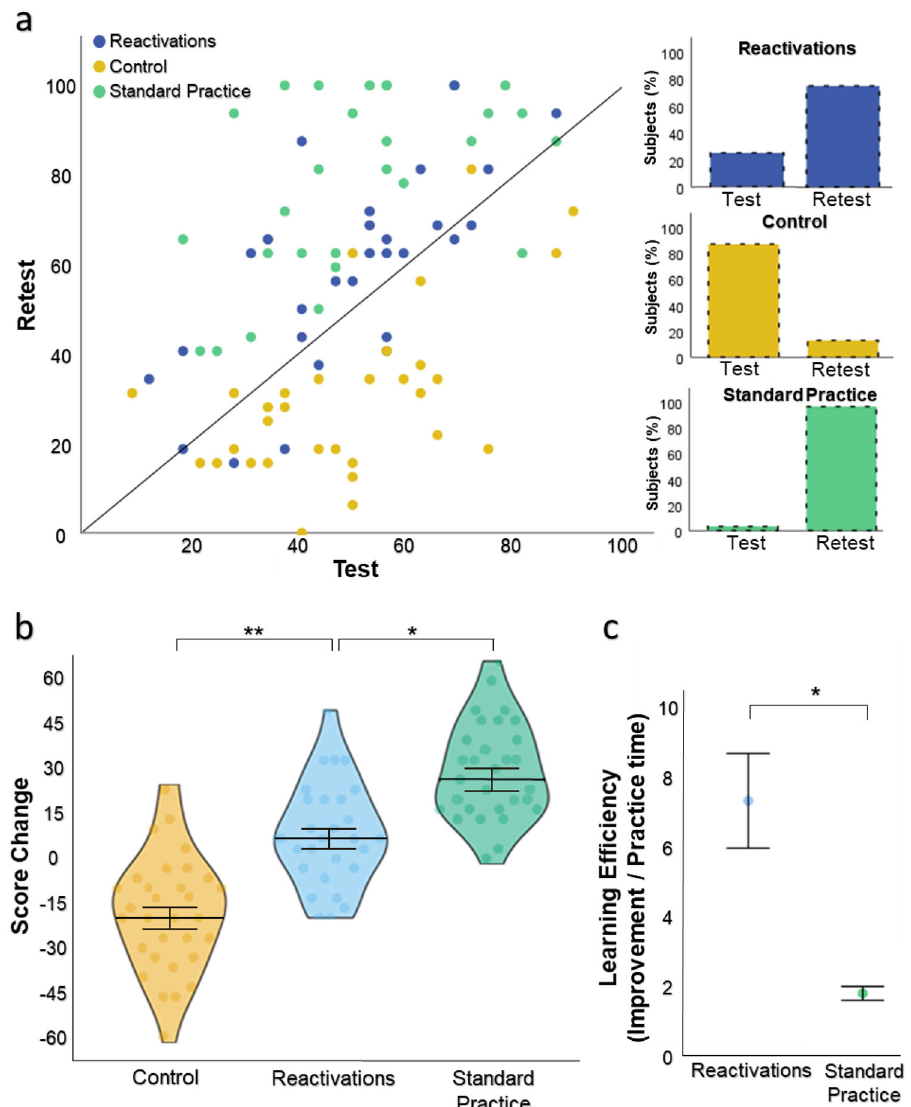
Fig. 2 Reactivation-induced learning gains. (a) Baseline test versus retest single-subject performance score, presented in a scatterplot along a unit slope line (y = x), where each point re fl ects a participant. Data accumulating above the unit line re fl ect participants who improved from test to retest, expressing learning gains, while data points below the line indicate degraded retest performance. Colored bars re fl ect the percentage of participants on each side of the unit slope line. (b) Violin graph showing the mean score change from test to retest sessions. Each point re fl ects a participant. (c) Subjects showing reactivation-induced learning were characterized by superior learning ef fi ciency relative to Standard Practice subjects showing learning, with higher rate of improvement (percent) per practice time (minutes). * P < 0.0002, ** P < 10 − 6 . Error bars represent standard error of the